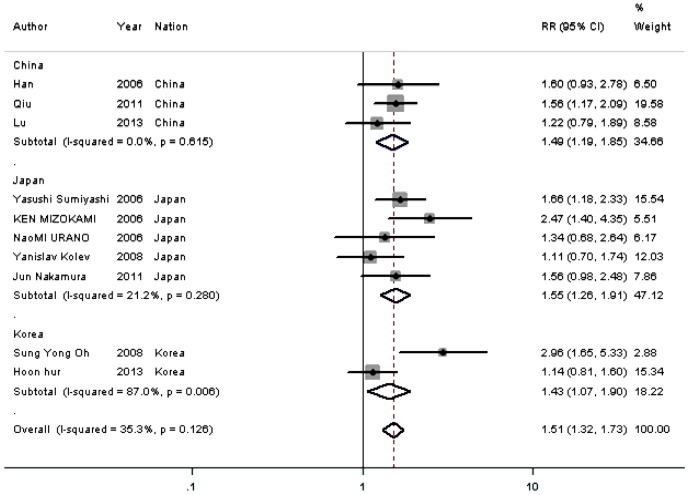
Meta-analysis on the relation between HIF-1α expression and 5-year overall survival (OS).The summary RR and 95% CIs were shown (fixed-effect model analysis).